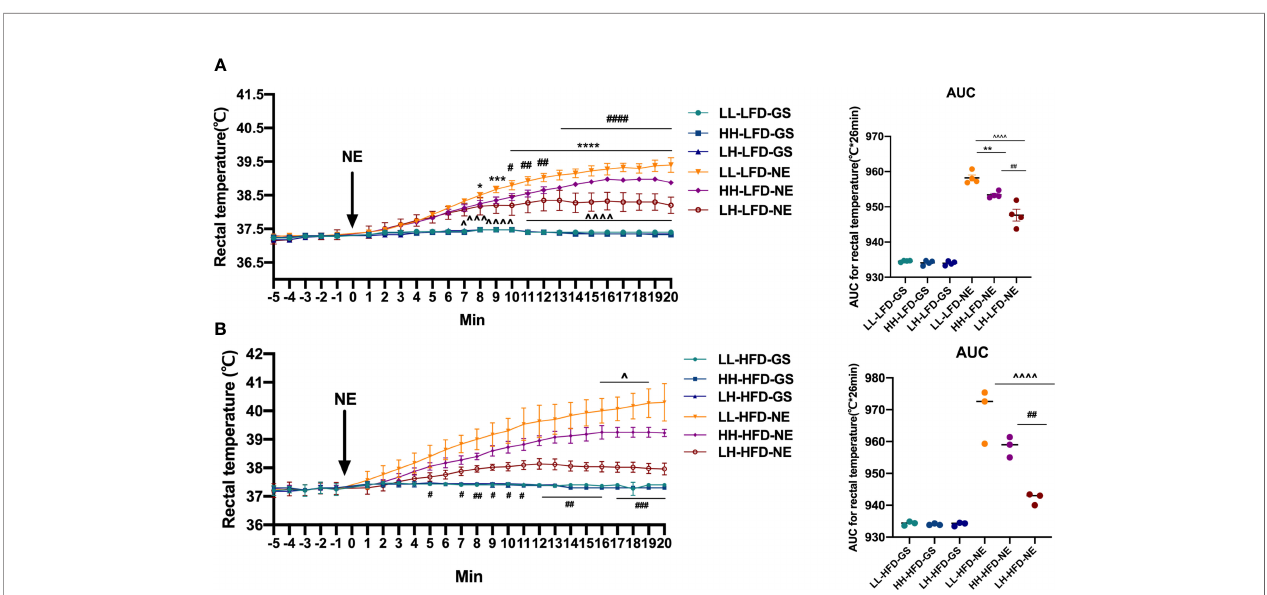
FIGURE 5 | Changes in rectal temperature of adult offspring after injection of NE/GS. Changes in rectal temperature of adult LL, HH, and LH mice fed LFD (A) or HFD (B) in 20 min after receiving NE or GS intraperitoneal injection (n = 4, from 4 litters). Data are expressed as the mean ± SEM. * p < 0.05, ** p < 0.01, *** p < 0.001, **** p < 0.0001: HH versus LL group. ^ p <0.05, ^^ p <0.01, ^^^ p <0.001, ^^^^ p <0.0001: LH versus LL group. # p < 0.05, ## p < 0.01, ### p < 0.001, #### p < 0.0001: LH versus HH